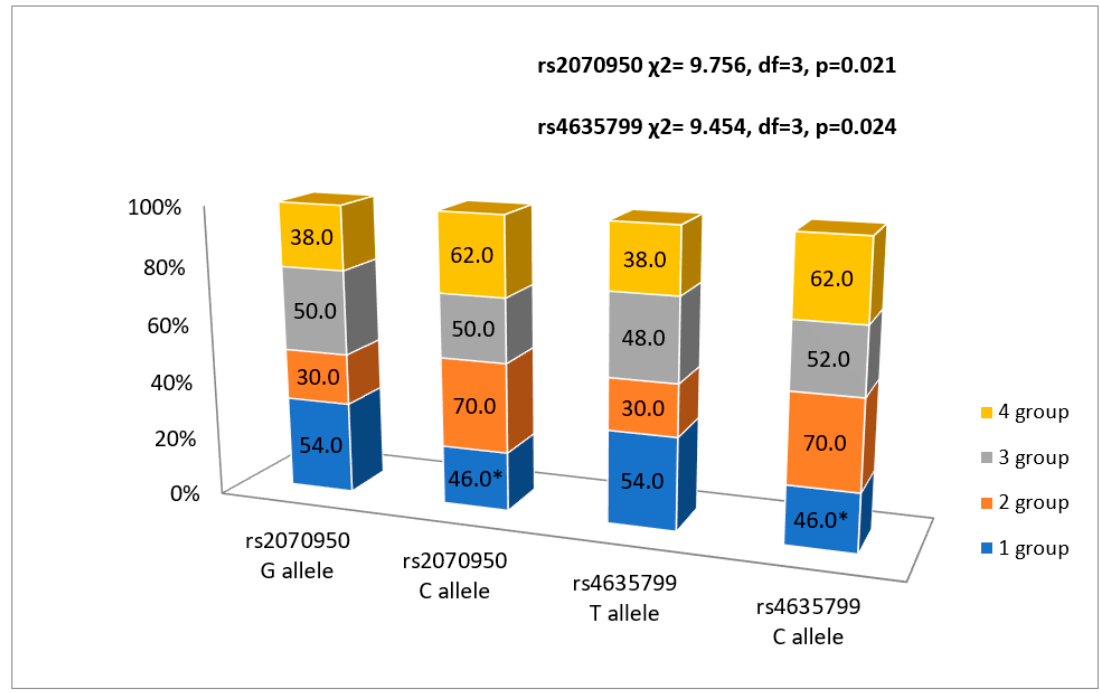
Figure 3. Association between rs2070950 and rs4635799 alleles and FLVR after MI groups. * p < 0.05 as compared with group 2.